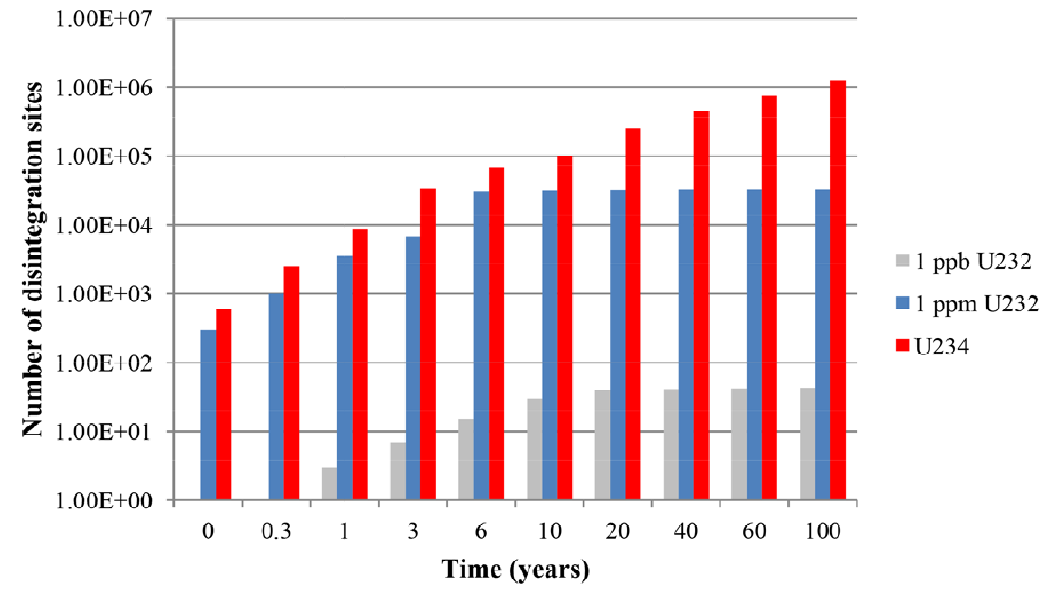
Figure 2. Comparison between